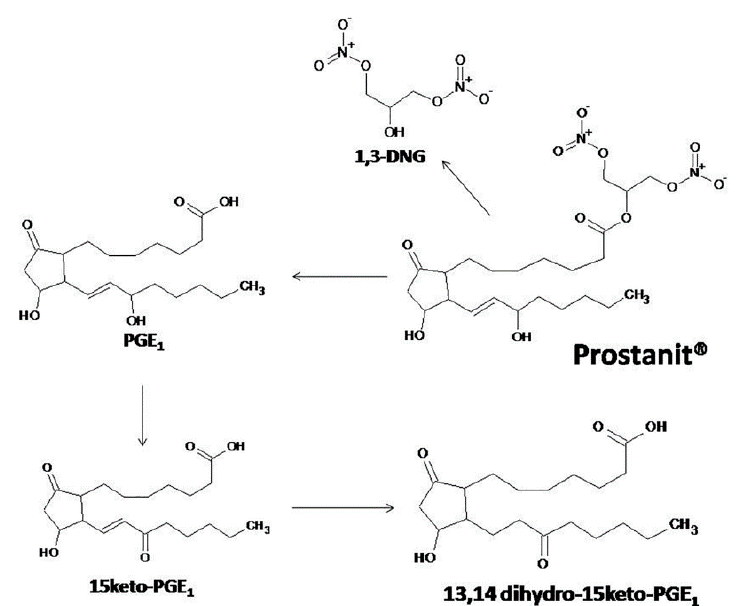
Figure 7. The proposed metabolism of Prostanit.